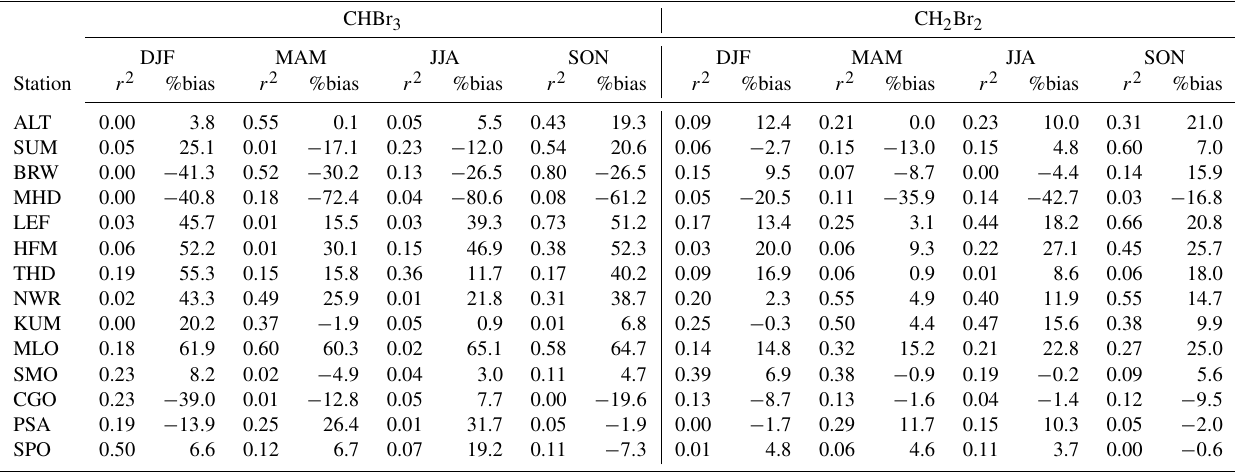
Table 3. Seasonal mean statistics for NOAA ground station sites (Table 2) showing Pearson correlations, r 2 , between observed and climato- logical monthly mean CHBr 3 and CH 2 Br 2 mole fraction data, and corresponding model